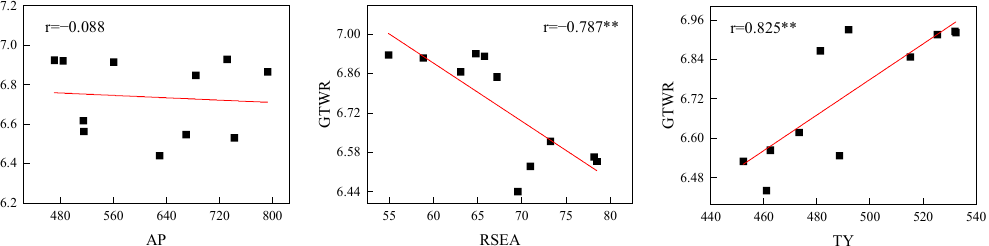
Figure 6. Correlation analysis of metrics related to gross total irrigation water requirement. Gross total water requirement (GTWR, m 3 ), planting proportion of wheat, beans, maize, flowers and vegetable (PWPA, PBPA, PMPA, PFPA and PVPA, %), total water resources (TWR, m 3 ), annual precipitation (AP, mm), ratio of water-saving irrigated area to effective irrigated area (RSEA, %), total yields (TY, kg). * Significance at the 0.05 probability level, ** Significance at the 0.01 probability level.